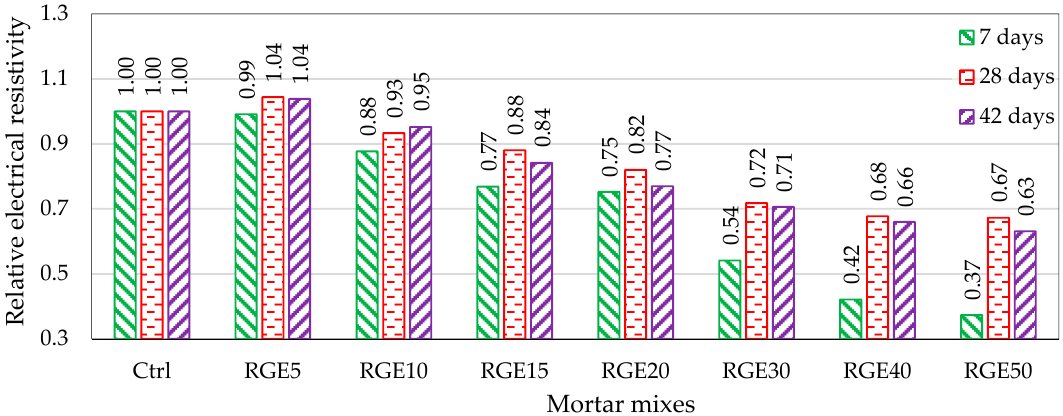
Figure 14. Electrical resistivity of all mortar mixes at 7, 28, and 42 days.